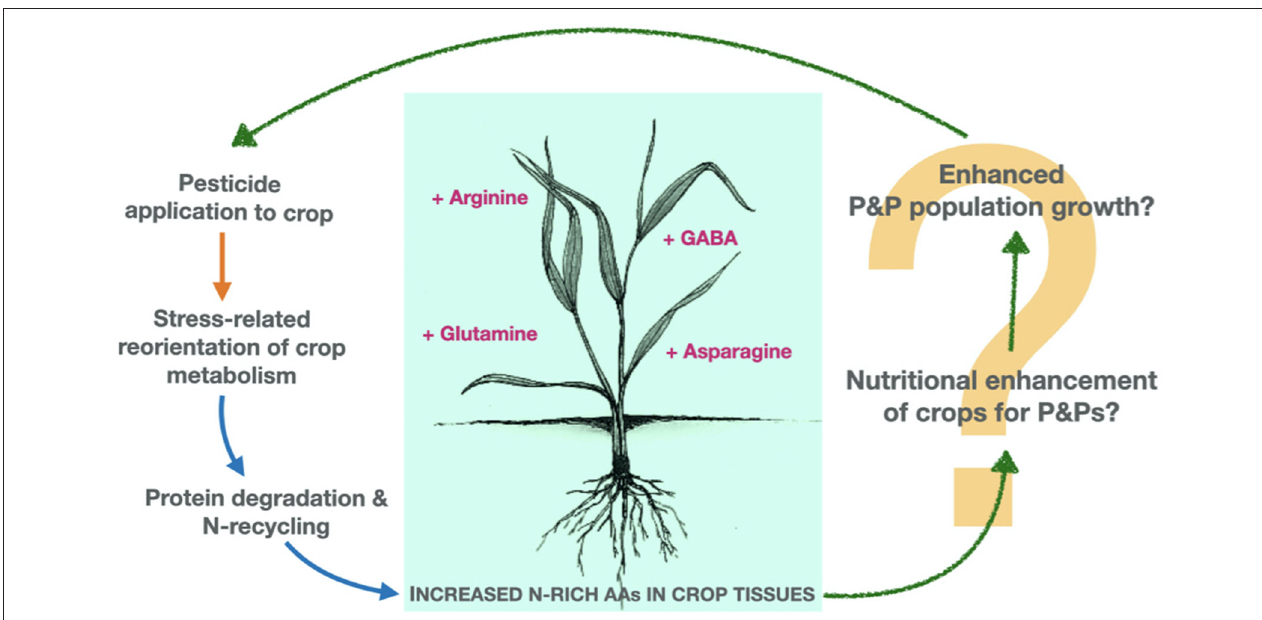
FIGURE 2 | Un-intended impacts of pesticide applications on crops’ biochemical susceptibility to subsequent pest and pathogen (P&P) damage. Exposure of crops to agronomically relevant concentrations of various pesticides can trigger a low-level “stress response” in the crop, resulting in subtle but significant metabolic disruption and accumulation of nutritionally valuable amino acids (AAs) within crop tissues. We hypothesise that pesticide-induced alterations to crop biochemistry may result in a favourable nutritional environment for P&P organisms (e.g., those not suppressed by the initial pesticide-application) to feed, develop, and proliferate. Subsequent P&P pressure may then trigger further applications of pesticide (orange arrow, agrochemical inputs; blue arrows, biochemical impacts; green “sketched” arrows, hypothesised ecological